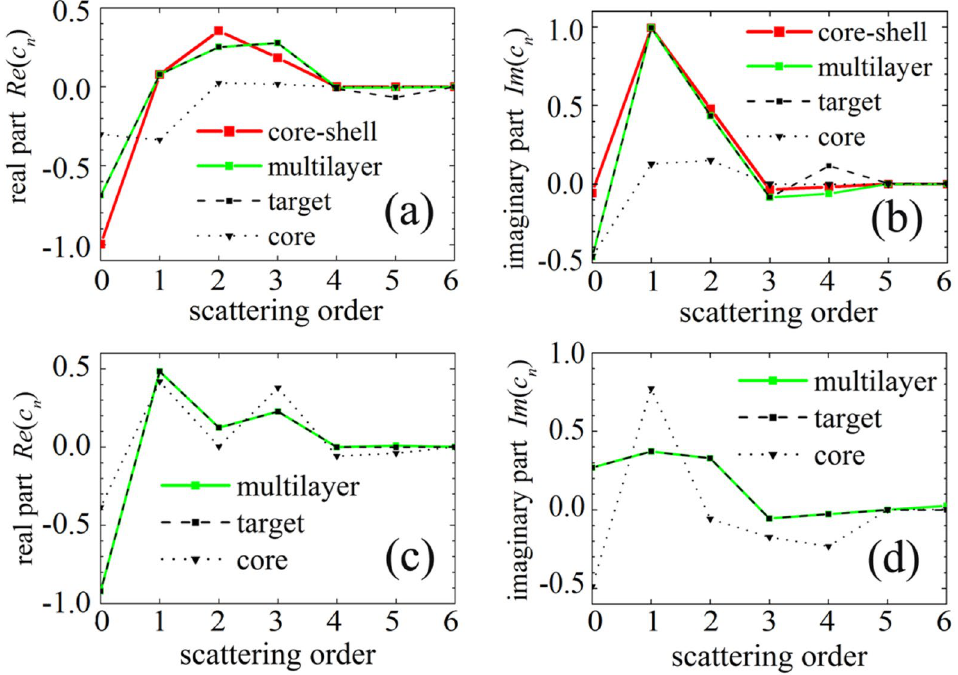
Figure 5. Real part (a) and imaginary part (b) of the Mie scattering coefficients for the core cylinder ( r c = λ 0 / 4, ε c = 2 ε 0 , μ c = μ 0 ), the target ( r t = λ 0 / 2, ε t = 6 ε 0 , μ t = μ 0 ), the optimized core–shell illusion device, and the optimized 3-layer device. Real part (c) and imaginary part (d) of the scattering coefficients for the PEC core ( r c = λ 0 / 2), the double-negative-material target ( r t = λ 0 / 3, ε t = −5 ε 0 , μ t = −0.5 μ 0 ), and the optimized 6-layer illusion